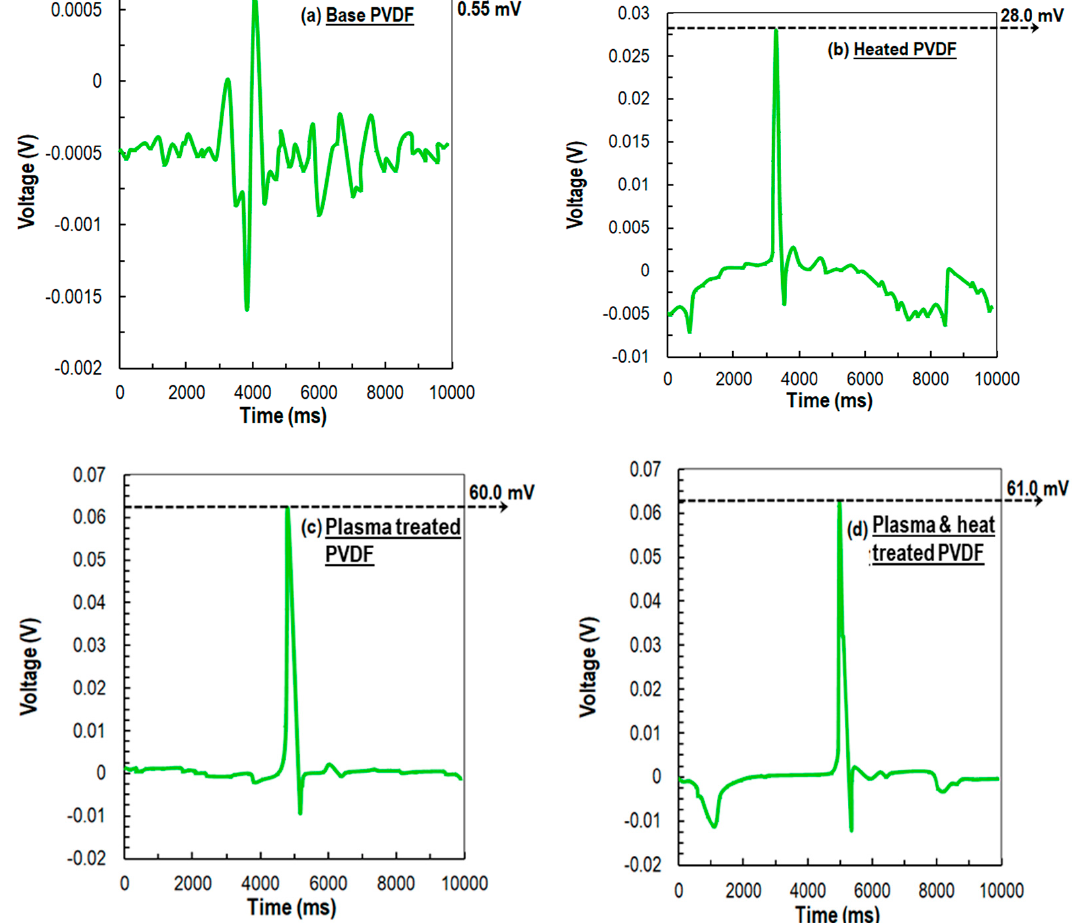
Figure 8. The average voltage gain characteristics from 20 experiments. ( a ) Base PVDF ( b ) heat treated PVDF ( c ) plasma treated PVDF ( d ) heated and plasma treated PVDF.